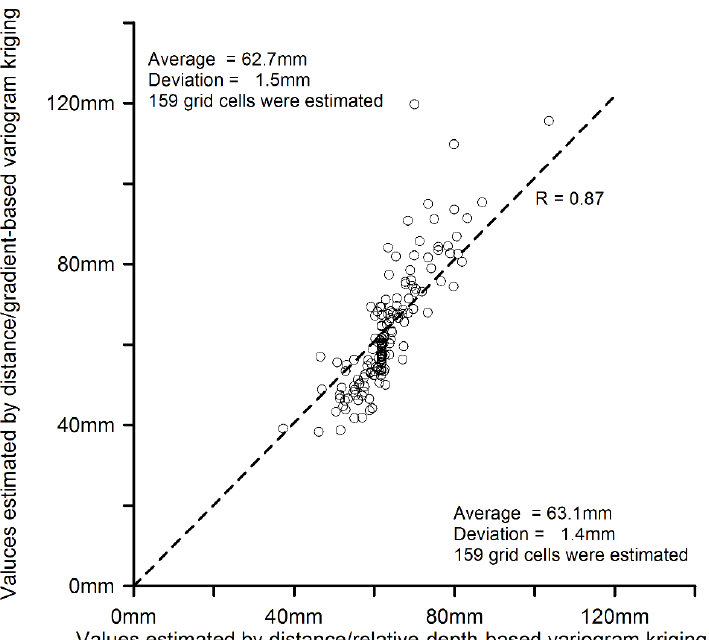
Figure 10. The estimated values of cobalt-rich crust thicknesses at 159 grid cells using two different kriging interpolation methods. The average, deviation, and correlation coefficient, R , between the two sets of values are indicated.